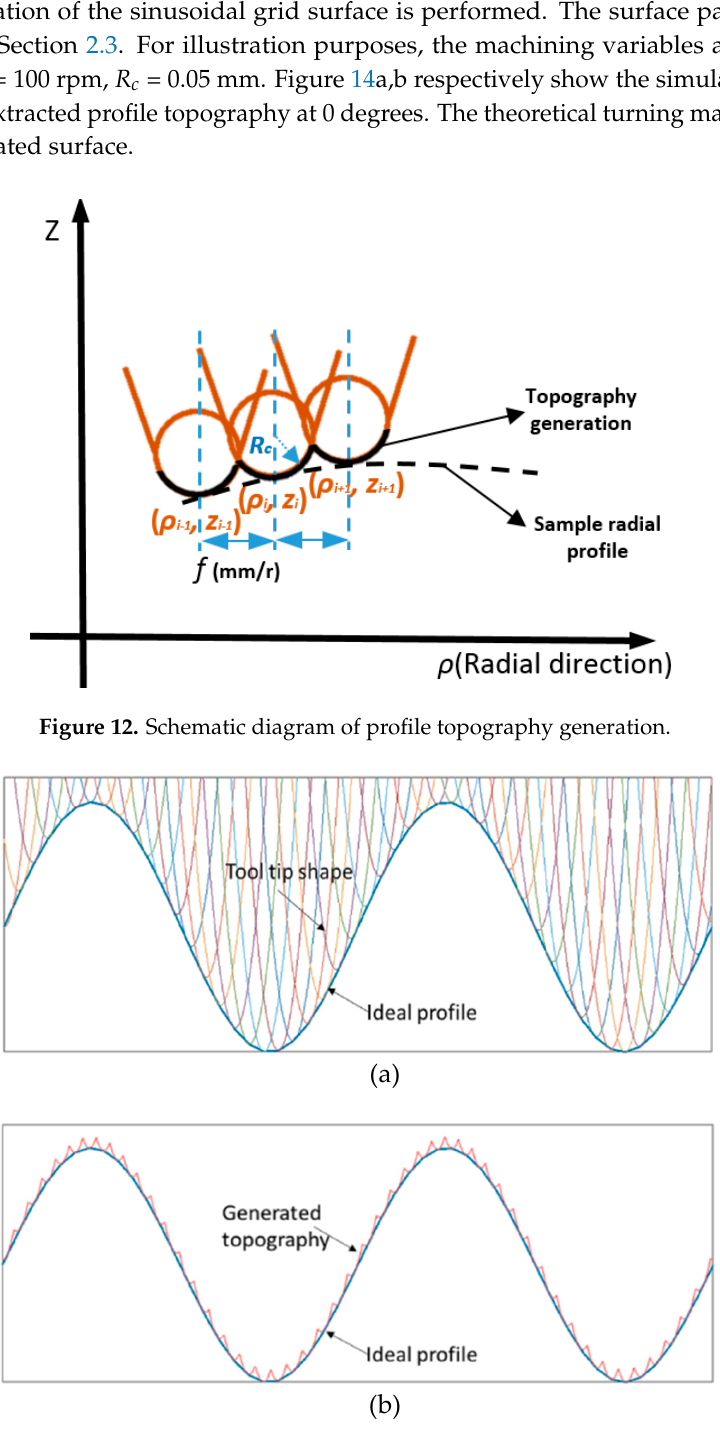
Figure 12. Schematic diagram of profile topography generation.